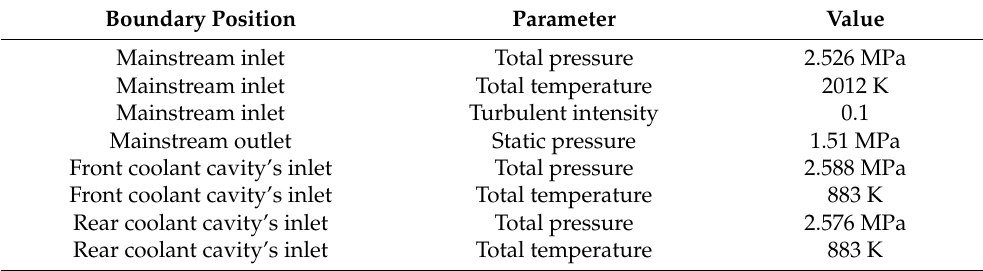
Table 3. Boundary conditions